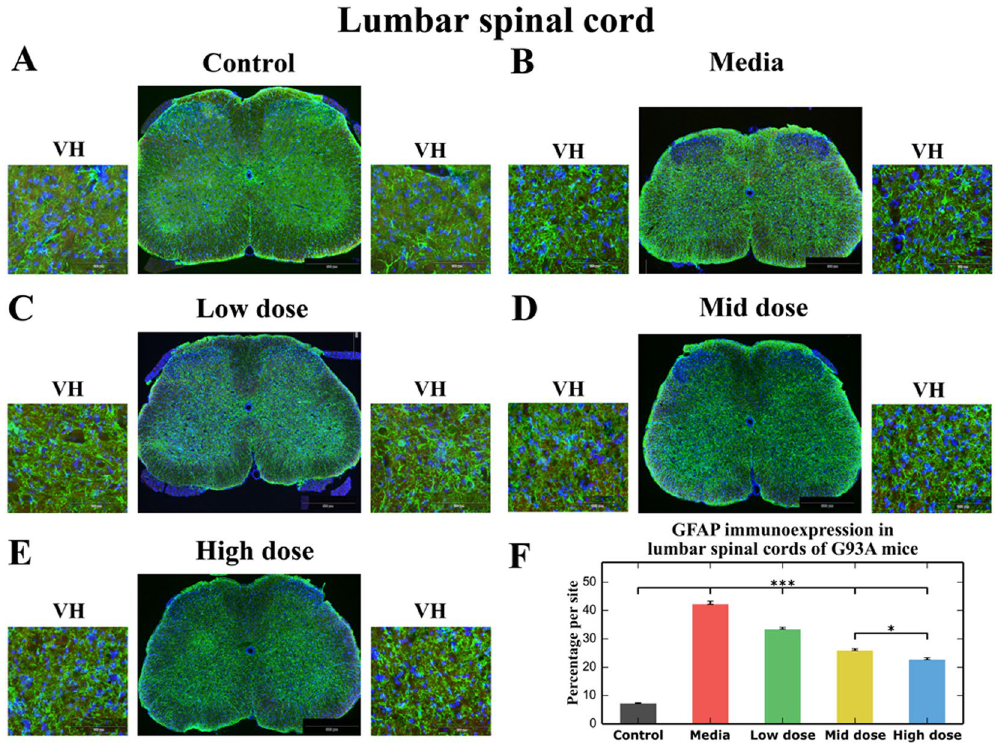
Figure 5. Characteristics of protoplasmic astrocytes in the lumbar spinal cord of G93A mice. Immunohistochemical staining of astrocytes using GFAP antibody (green) in ( A ) control mice showed cells with typical cellular morphology, whereas ( B ) numerous astrocytes with large cell bodies and thick processes were observed in media-injected mice at 17 wks of age. Astrocyte cell reactivity was reduced in the ventral horns of ALS mice treated with low ( C ), mid ( D ), or high ( E ) cell doses. In cell-treated animals, many astrocytes with distinctive fine cell processes at low density were detected. Scale bar in A-E for full coronal spinal cord section is 500 µ m and in ventral horn insert is 100 µ m. ( F ) GFAP fluorescence in the lumbar ventral horns was significantly upregulated in media-injected mice vs. controls. Significantly decreased GFAP immunoexpression was associated with elevated cell doses. * p < 0.05, *** p <